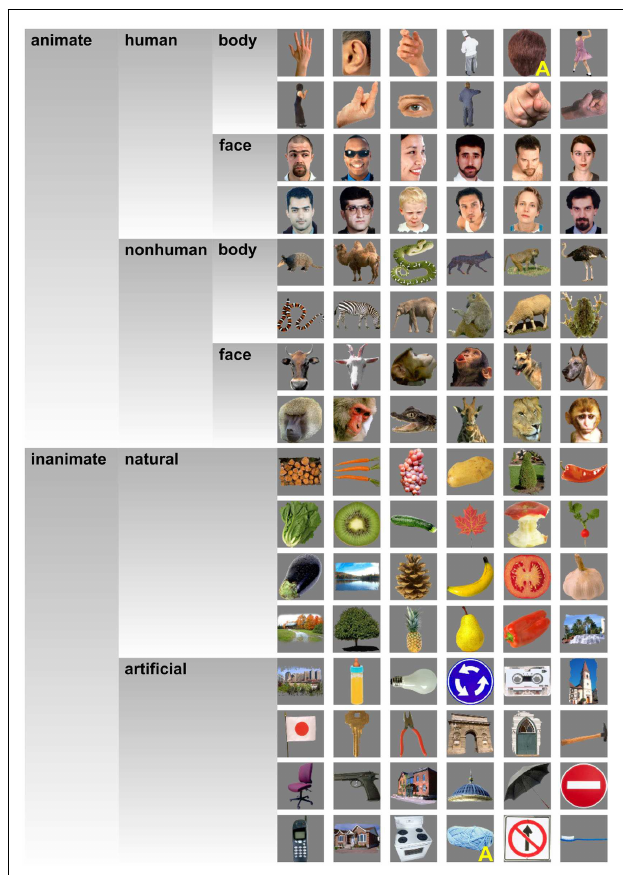
FIGURE 1 | Stimuli. This figure shows the object images that we presented to our subjects.Two stimuli were described as ambiguous by several of our subjects during debriefing.These stimuli (back of a human head, knitting wool) are marked with a yellow “A.”This figure is adopted from Kriegeskorte et al.